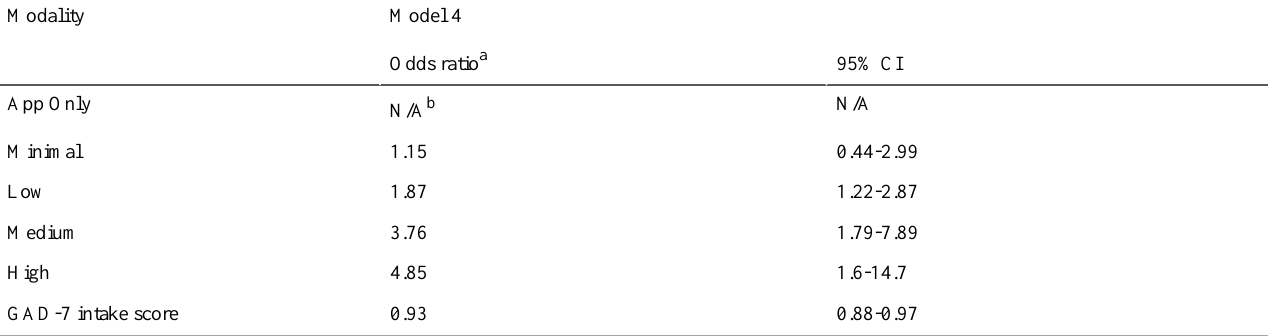
Table 6. Associations between utilization and improvement among the combined-care cohort